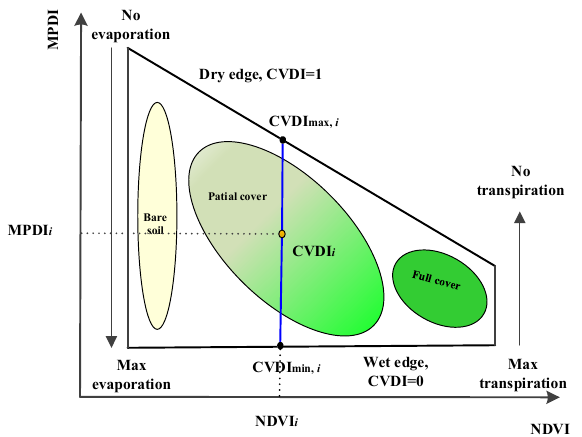
Figure 3. MPDI-NDVI feature space and definition of the condition vegetation drought index (CVDI) (reproduced from Sandholt et al. [19]).